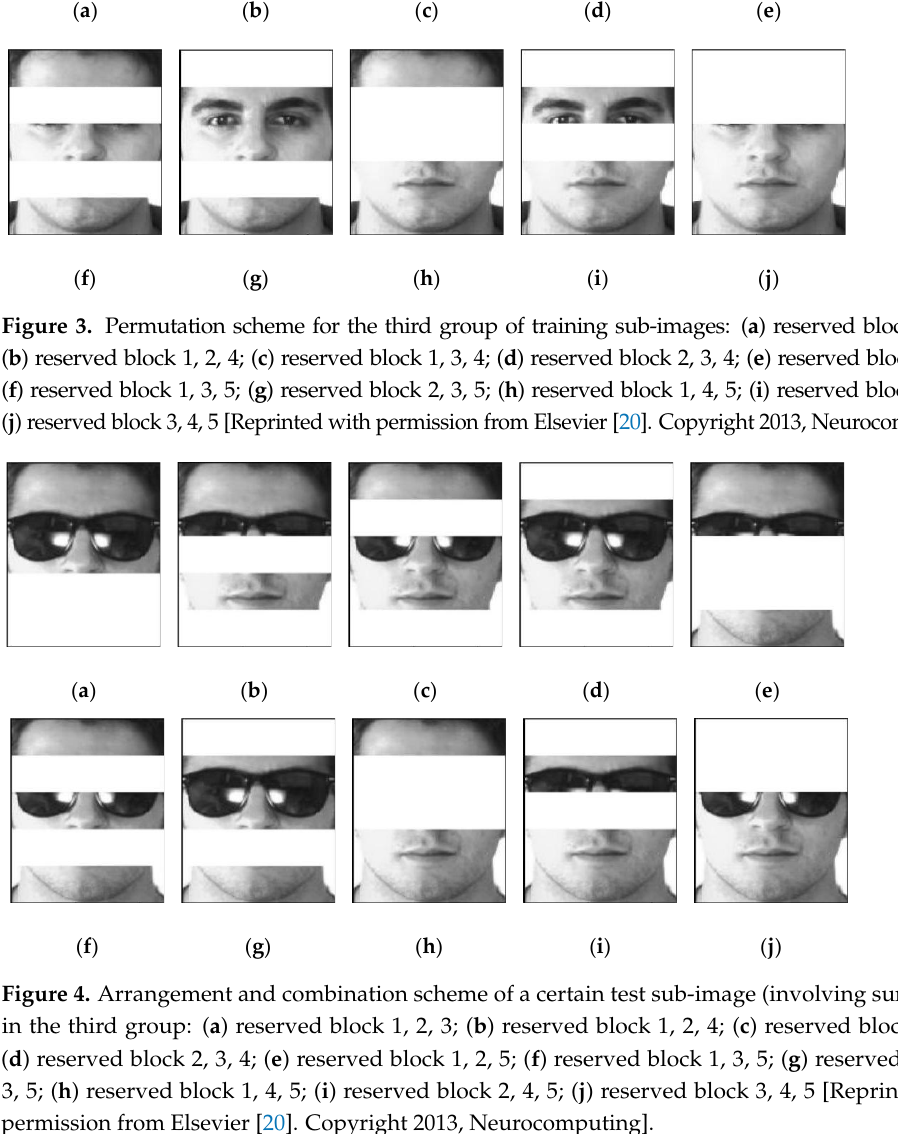
( b ) Figure 2. Faces from the AR subset occluded by sunglasses and scarves: ( a ) face images occluded by sunglasses; ( b ) face images occluded by scarves [ Reprinted with permission from Elsevier [20]. Cop- yright 2013, Neurocomputing. ] . In this paper, the block arrangement method was adopted. All the blocks were ar- ranged, combined, and finally compared to the residual values of each scheme to deter- mine the final arrangement (see Figures 3–5). During this process, the approximate posi-